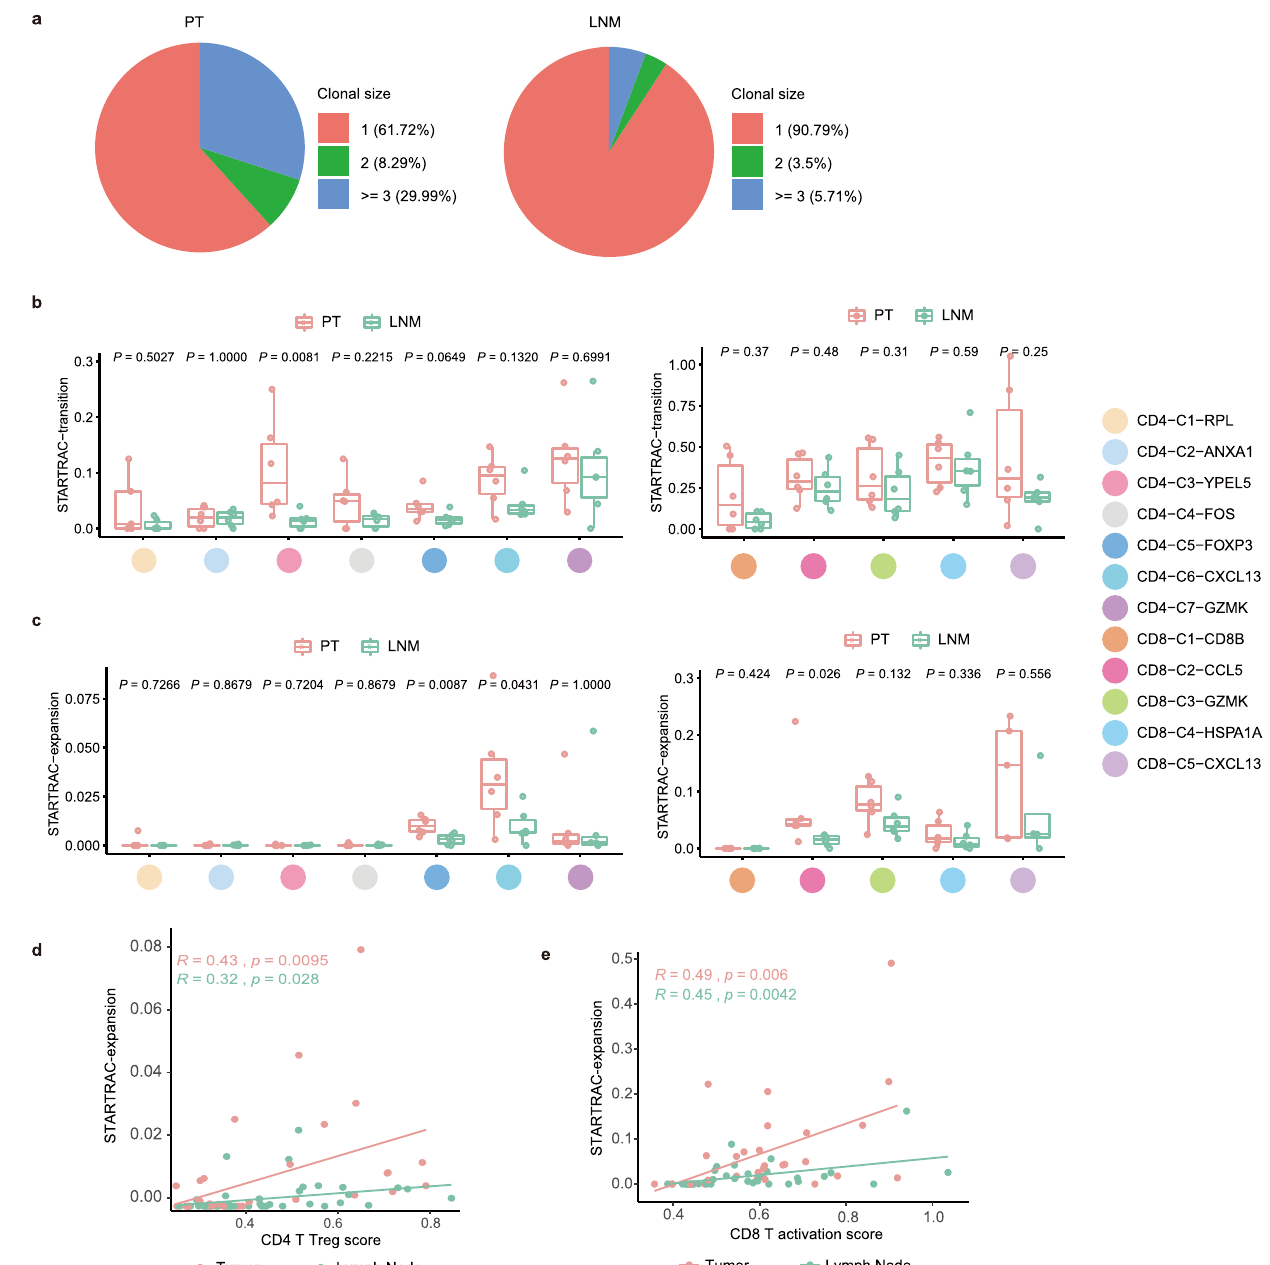
Fig. 3 | T cellsin PThave higherexpansion and transitionability thanthose in LNMT. a Pie charts showing the fraction of clonal size of shared clonotypes in tumor(left)orLNMT(right).Redrepresentsuniqueclonotypes,greenrepresentsa clonal size of shared clonotypes of 2, and blue represents the clonal size of shared clonotypes of 3 or above. b Developmental transition of CD4 T clusters (left) and CD8 T clusters (right) quanti fi ed by STARTRAC-transition for each patient ( n =6) within each tissue. Two-sided Wilcoxon test. In the box plots, the center line cor- responds to the median, box corresponds to the interquartile range (IQR), and whiskers 1.5×IQR. c Clonal expansion of CD4 T clusters (left) and CD8 T clusters (right) quanti fi ed by STARTRAC-expansion for each patient ( n =6) within each